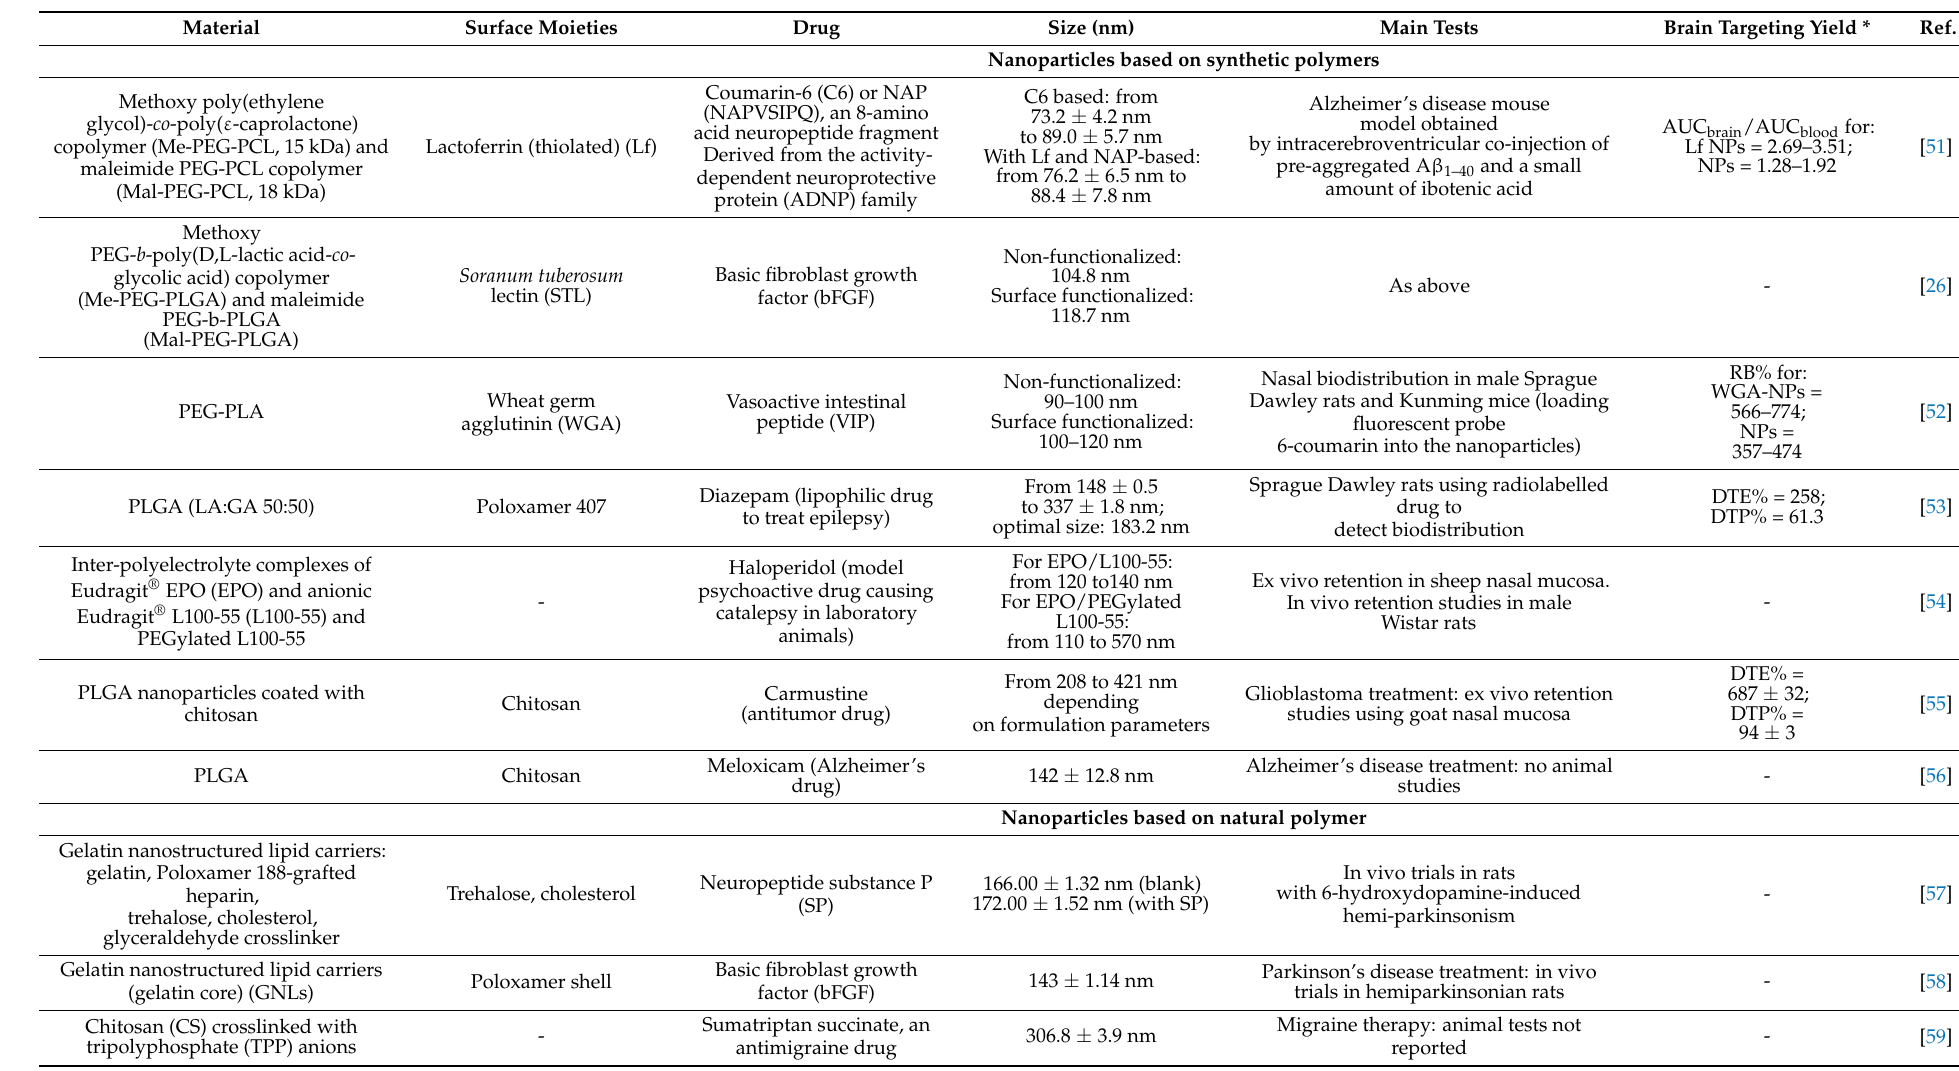
Table 2. Main nanocarriers exploited in IN drug delivery to treat brain